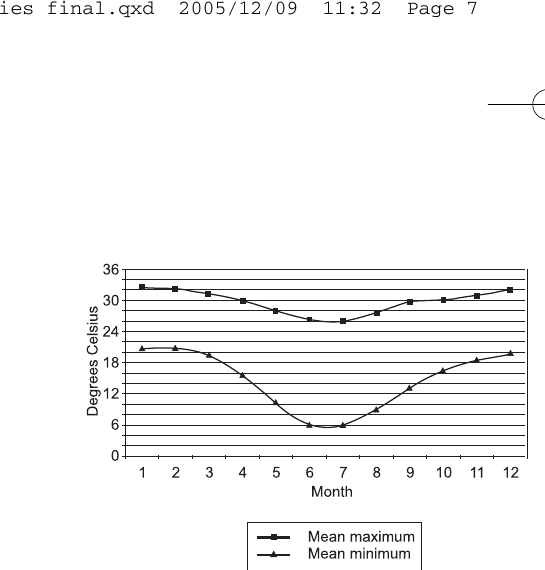
Fig. 2. Average monthly maximum and minimum temperature (°C) for the period 1960 to